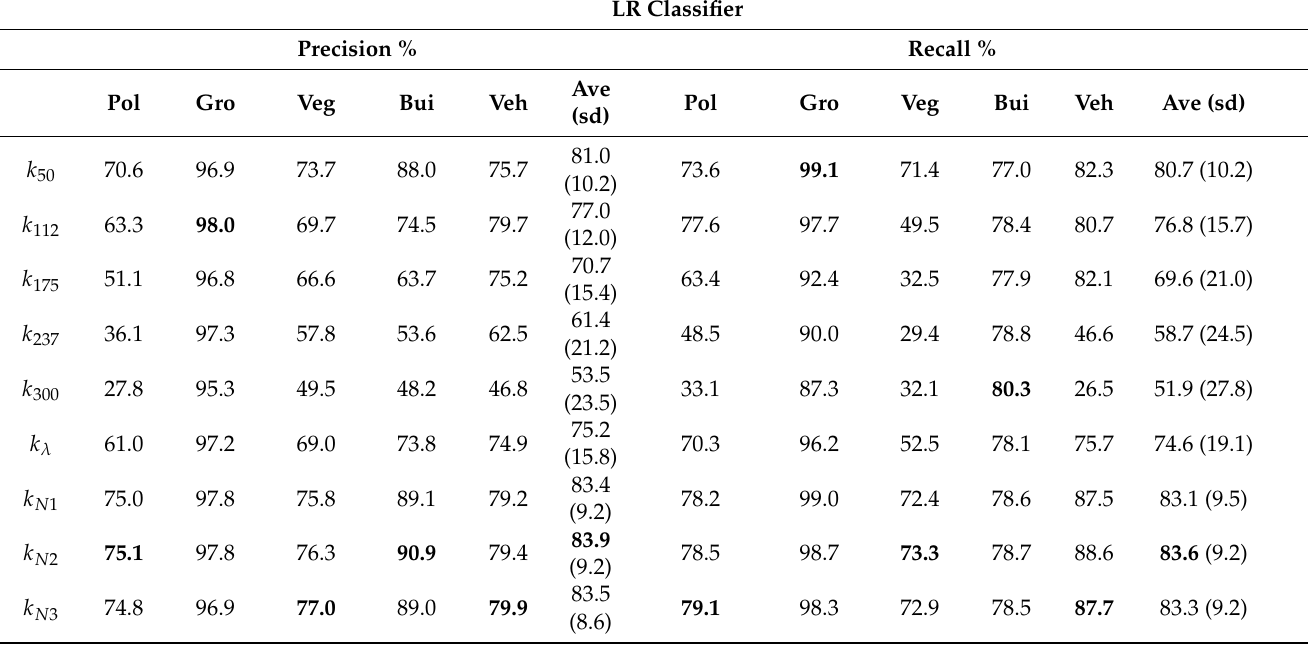
Table 6. Metrics (precision and recall) of the classification by classes using LR and SVM for different scales in a test sample n p = 2000. The numbers in bold represent maximum values in each column. Both metrics correspond to the average values in 100